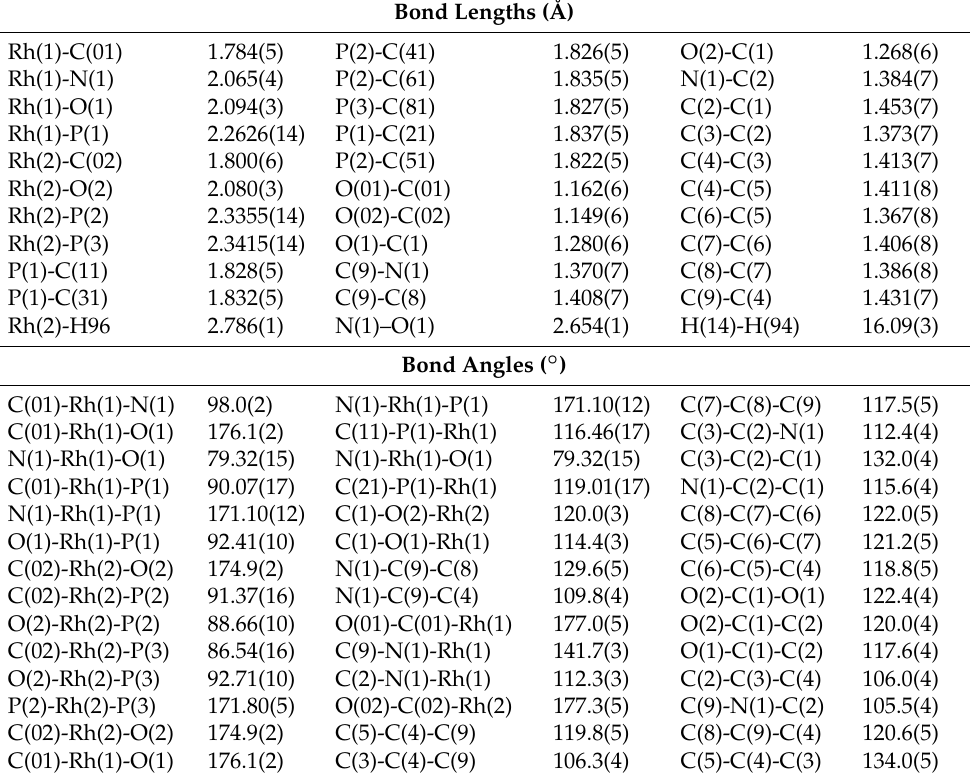
Table 2. Bond lengths [Å] and angles [ ◦ ] for [Rh 1 (Indol (cid:48) )(CO)(PPh 3 )Rh 2 (CO)(PPh 3 ) 2 ] · (CH 3 COCH 3 ) ( B2a